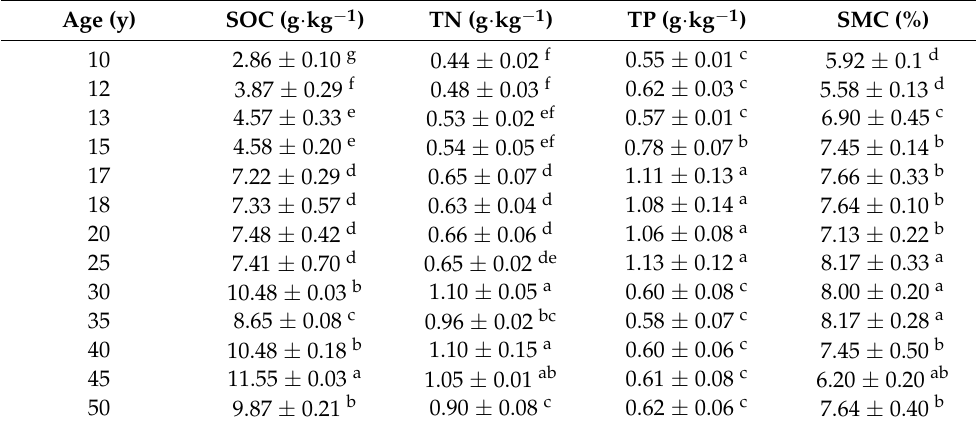
Different letters within a column indicate significant differences at p <